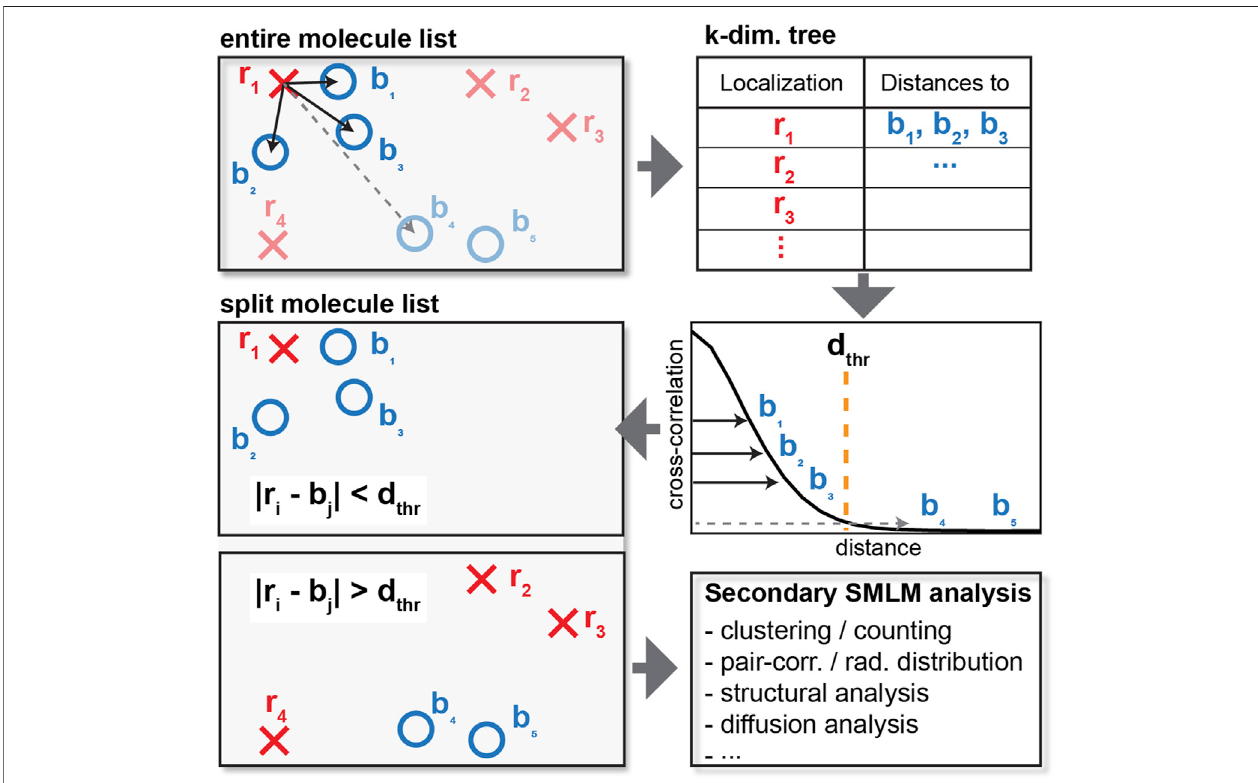
FIGURE 1 | Schematics of cross-correlation. For each localization of one type (red crosses), the distance to each of the other type (blue circles) is computed and tabulated. Instead of calculating the distance of every pair of red crosses and blue circles, a distance cutoff is applied to only consider interparticle distances within relevantlengthscales. Whenthedistanceexceeds thecutoffasshown bythedashed line,thedistanceisnot tabulated, resultinginreducedmemoryrequirements. The list of localization can then be split into localization that do and do not colocalize or appear within the speci fi ed distance cutoff for further downstream